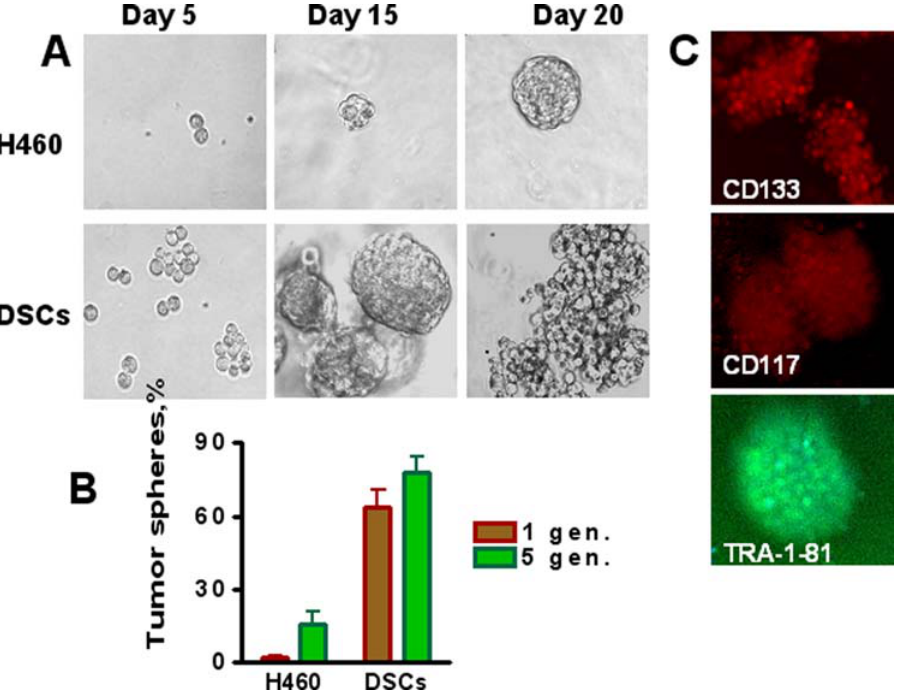
Figure 5. Chemotherapy selectively enriches for self-renewing lung cancer cells. Parental H460 cells and DSCs (1000 cell/ml) were plated onto ultra low adherent plates in MC-based serum free media supplemented with growth factors and cultivated as described in Material and Methods. Tumor spheres generated from single-cell suspension cultures of parental H460 cells and drug survived CSCs were counted after 3 weeks of culture (1 st generation), and then spheres were dissociated and replated as described in Material and Methods. A, Lung tumor spheres generated from single-cell cultures of parental H460 cells and DSCs, imaged on indicated day of culture. B, Maintenance of enhanced ability to form tumor spheres during several generations of DSCs transfer (for comparison only 1-st and 5-th generation’s data are presented). C, Immunofluorescent images of lung tumor spheres stained for CD133, CD117 and TRA-1-81 (10X objective).